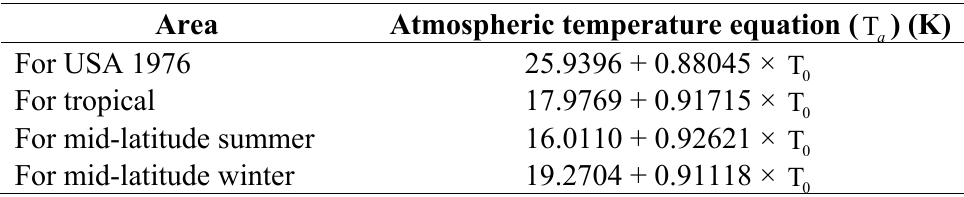
Table 5. Estimation of mean atmospheric